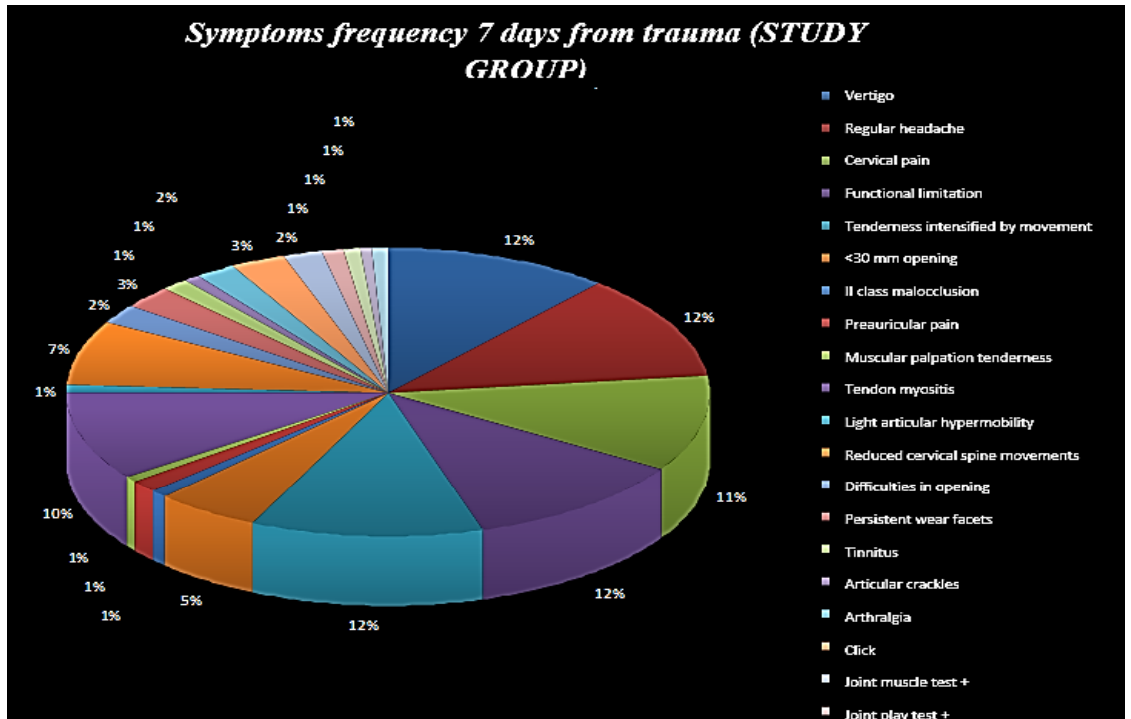
Figure 5. Symptom frequency 7 days from trauma (study group).